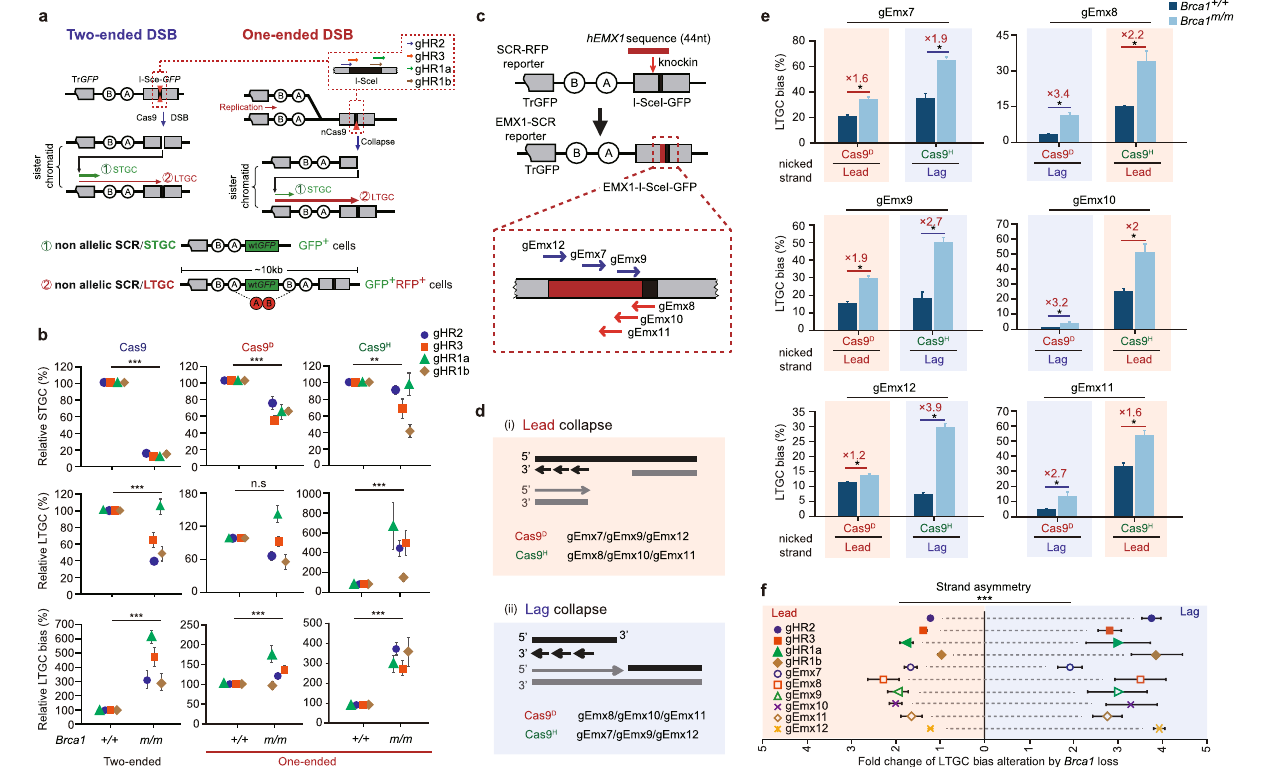
Fig. 2 | BRCA1 suppresses nick-induced LTGC bias in a strand-asymmetric manner. a Schematic of the SCR-RFP reporter and HR repair products induced by Cas9andnCas9.Cas9inducestwo-endedDSBswhereasnCas9-inducednickscould be converted into one-ended DSBs by DNA replication. STGC and LTGC in non- allelic SCR induced by Cas9 or nCas9 generate GFP + RFP − cells and GFP + RFP + cells with a TD span size at ~10kb as indicated, respectively. Only one direction of one- ended DSBs is expected to result in GFP + RFP + cells and the direction of DNA replication generating such one-ended DSBs is indicated. Gray boxes: TrGFP and I- Sce-GFP ; green box: wt GFP ; circles A and B: two arti fi cial RFP exons. Four sgRNAs targeting the I-SceI site are denoted. b Relative STGC (top), LTGC (middle) and LTGC bias (bottom) induced by Cas9 or nCas9 together with each of 4 sgRNAs as indicated in isogenic Brca1 +/+ and Brca1 m/m mESC. Relative STGC, LTGC and LTGC bias are derived from the original measurements in Supplementary Fig. 4c by normalizing STGC, LTGC and LTGC bias in Brca1 +/+ cells to 100%. c Schematic for generation of the EMX1-SCR reporter in mESC. The EMX1-SCR reporter was gen- eratedby knock-in of a 44-nt h EMX1 sequenceasindicated at 5 ’ of the I-SceI site of the SCR-RFP reporter in mESC. Among 6 sgRNAs targeting the EMX1-I-SceI site,